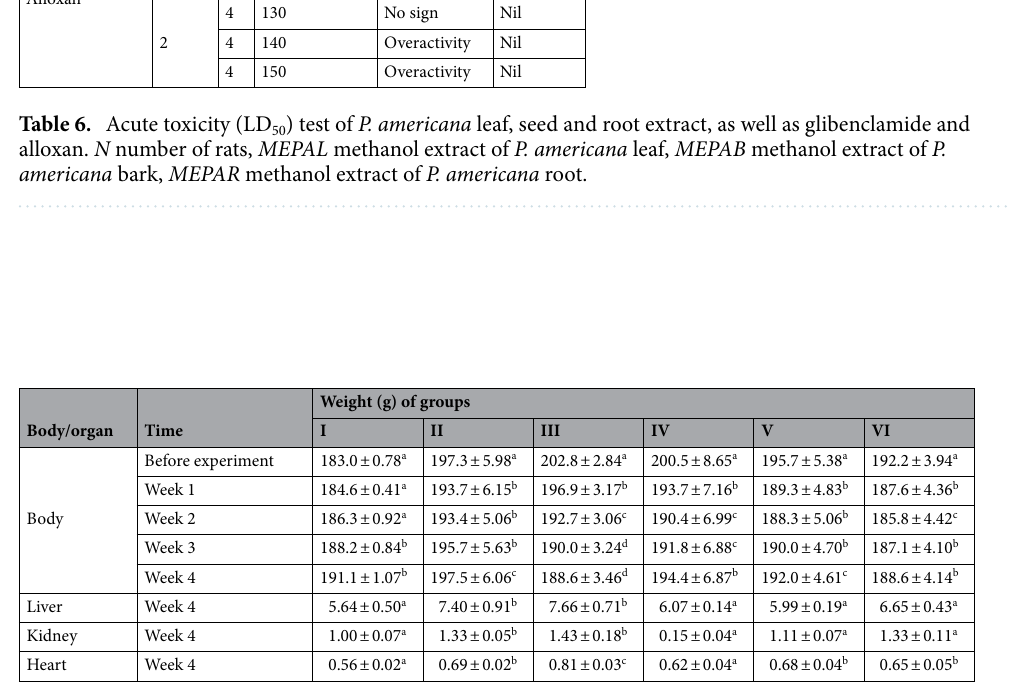
Table 7. Effect of P. americana extracts on the body weight and selected organs (Liver, Kidney, Heart) of alloxan–induced diabetic rats. Values represent mean ± standard deviation (n = 5). Values with different superscripts (a,b,c,d) along the same group are significantly different from one another (P < 0.05). Group I— normal control rats, Group II—diabetic rats treated with glibenclamide, Group III—diabetic rats not treated, Group IV—diabetic rats treated with methanol extract of P. americana bark, Group V—diabetic rats treated with methanol extract of P. americana leaves, Group VI—diabetic rats treated with methanol extract of P. americana root.